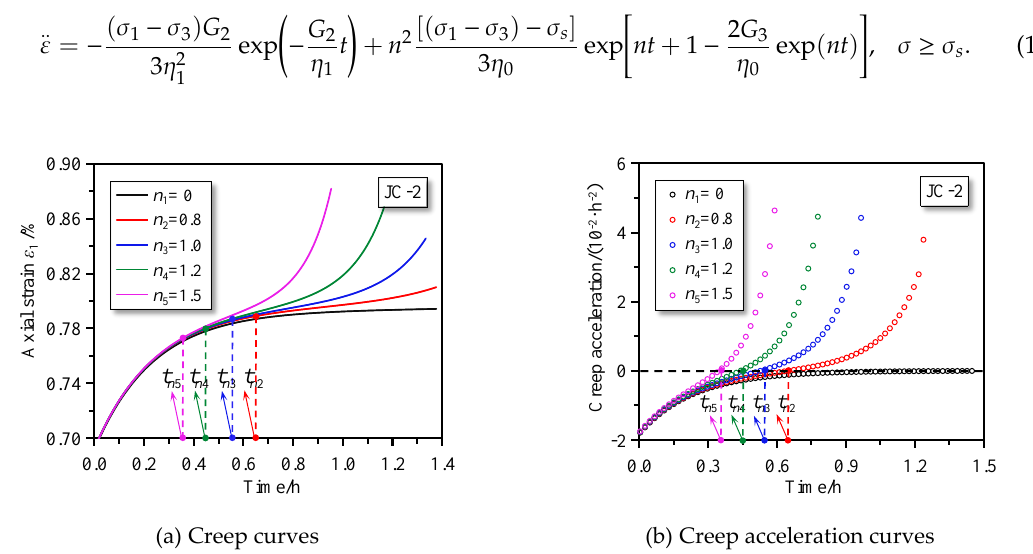
Figure 13. Creep and creep acceleration curves with di ff erent accelerating creep exponents n.